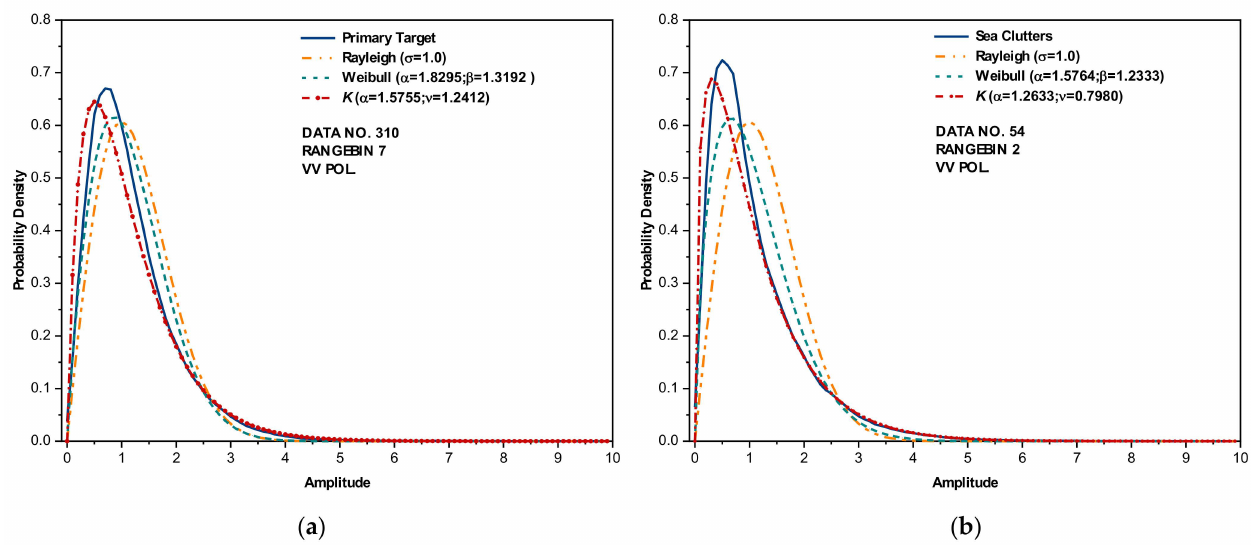
Figure 1. The probability density of sea clutter and Rayleigh, Weibull and K distributions with estimated shape parameters: ( a ) sea primary target and ( b ) sea clutter